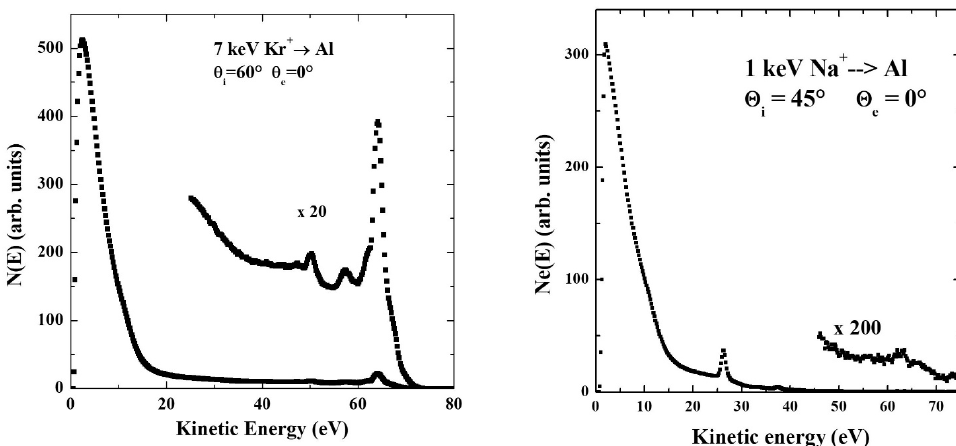
Figure 7. Spectra for 7 keV Kr + on Al ( left ) and for 1 keV Na + ( right ), extended to reveal the features due to the Auger decay of 2p excited Al target atoms In the 55–70 eV.